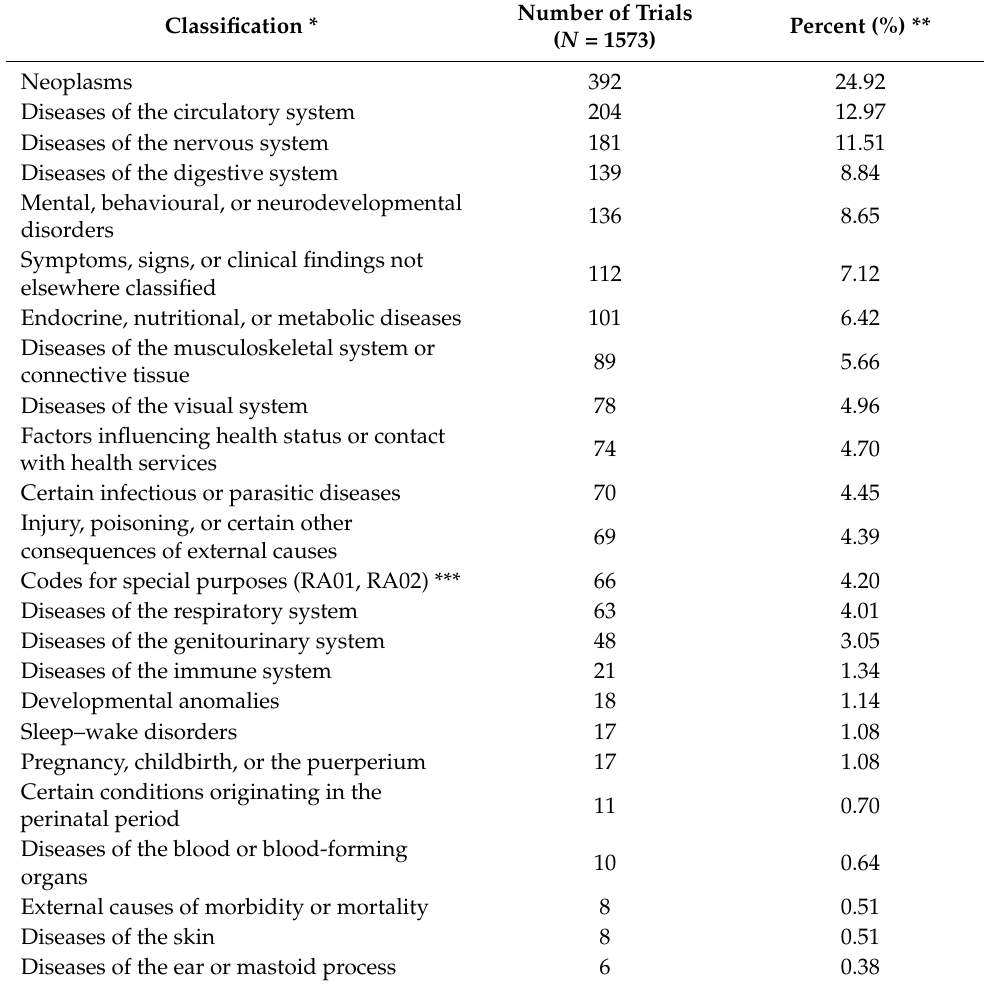
Table 6. Disease areas of AI-related trials by ICD-11.